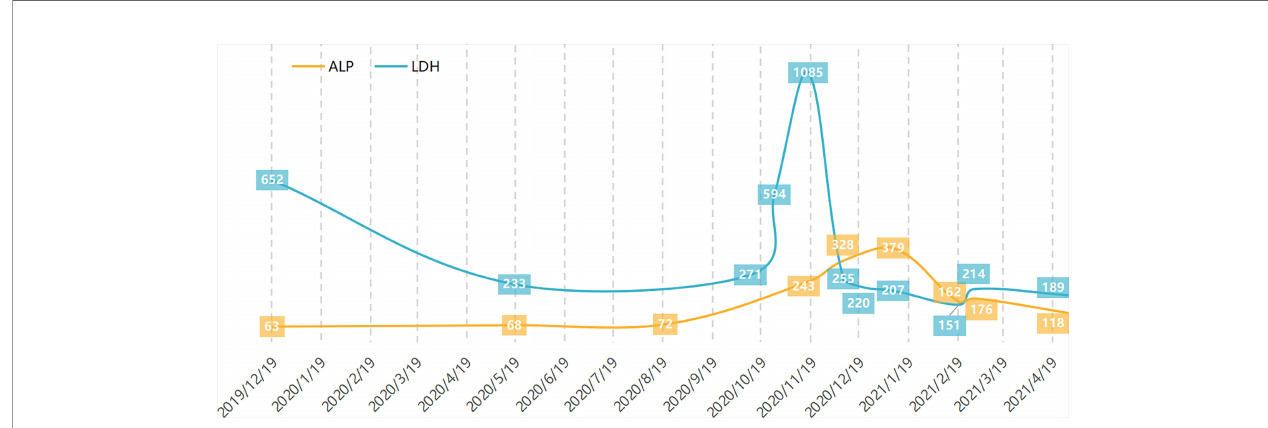
FIGURE 2 | Alkaline phosphatase and lactase dehydrogenase changes during treatment